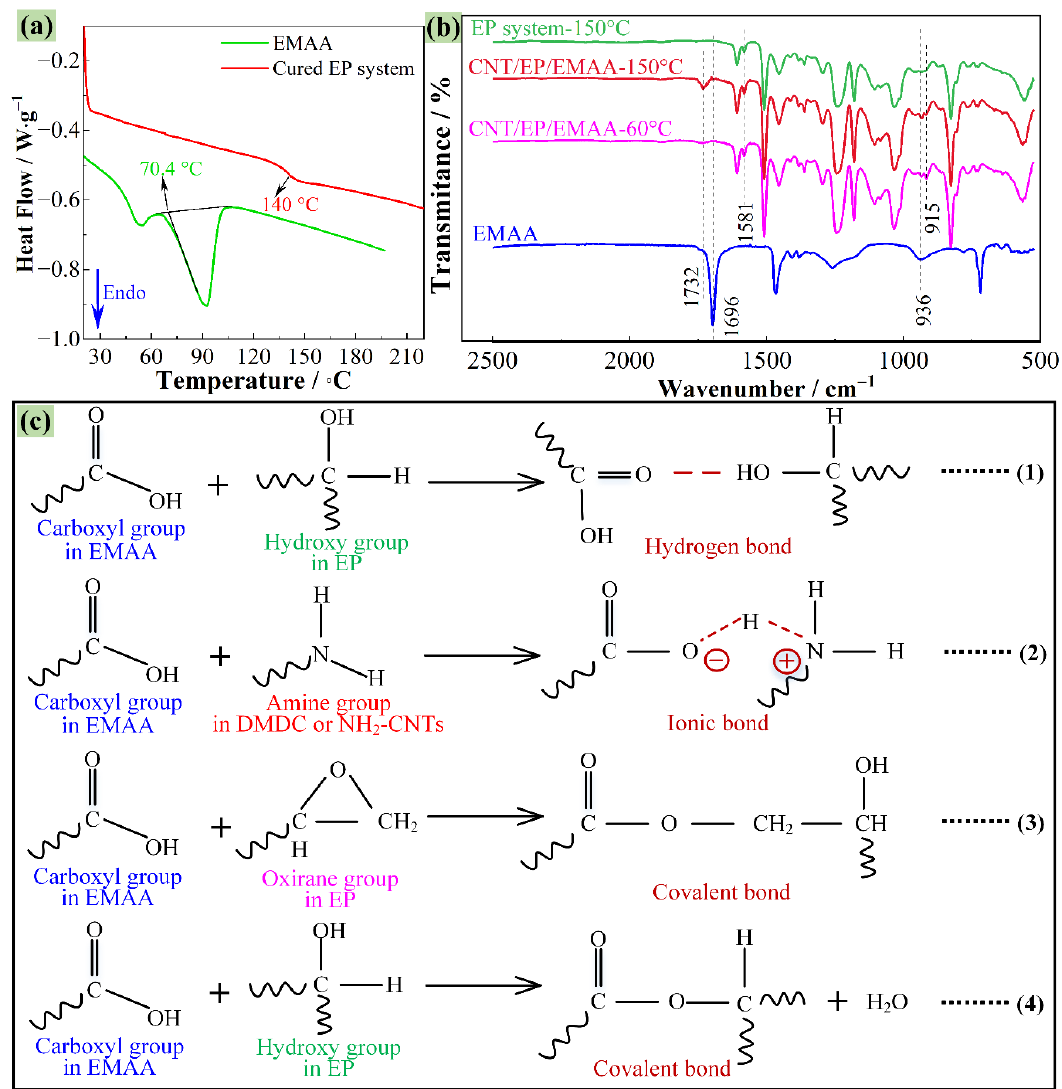
Figure 3. ( a ) DSC curves of EMAA and cured epoxy system, ( b ) FTIR spectra of EMAA, EP, and CNT/EP/EMAA system, ( c ) potential reactions between EMAA and epoxy and harder groups and